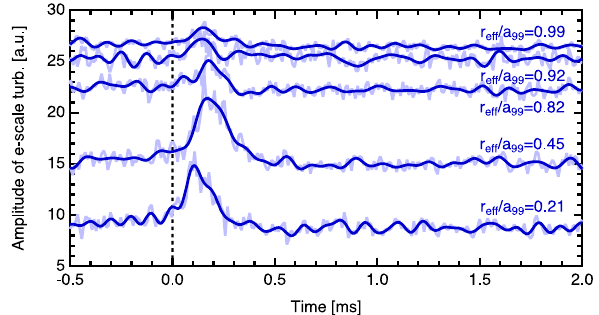
Figure 6. Time evolutions of the electron scale turbulences for different radial positions obtained from the W-band back-scattering measurement. The light-blue lines show the raw data, and dark-blue lines show the data after low-pass processing below 20 kHz.